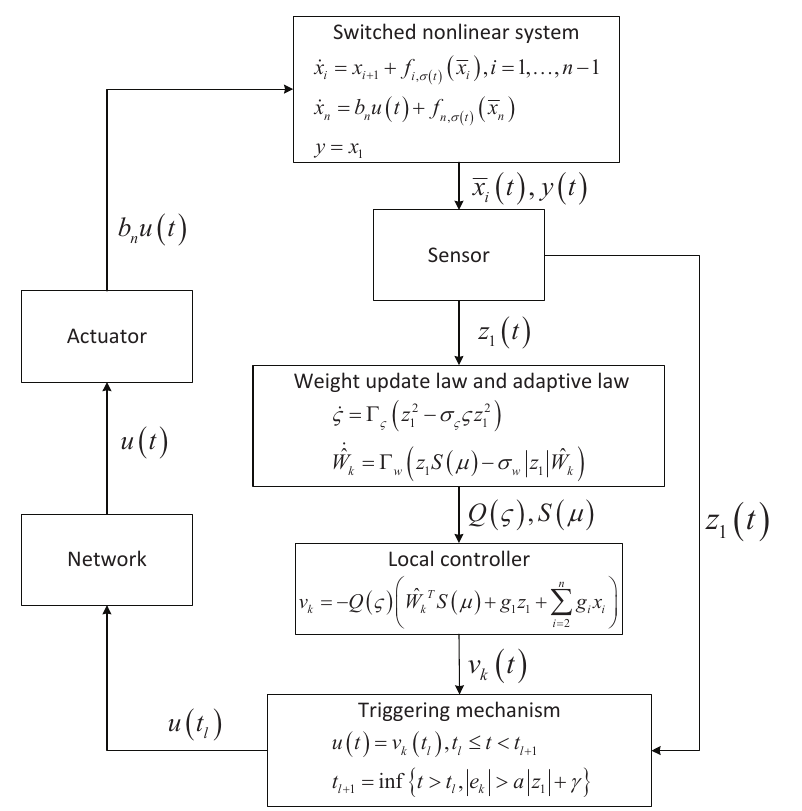
Figure 10. The main frame of the